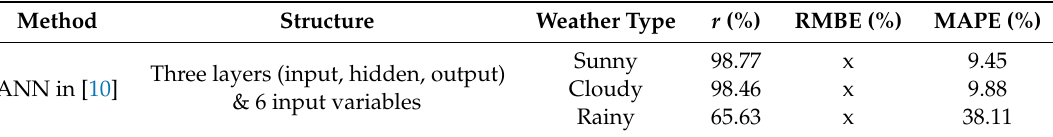
Table 3. Summary of One-Day-Ahead Forecast Errors for 4